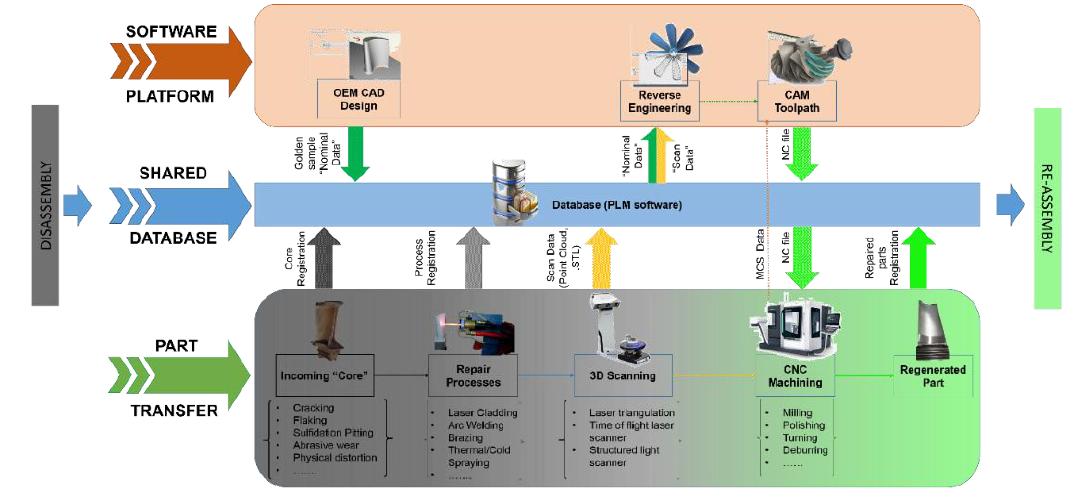
Figure 2. Smart remanufacturing cell-process flow.